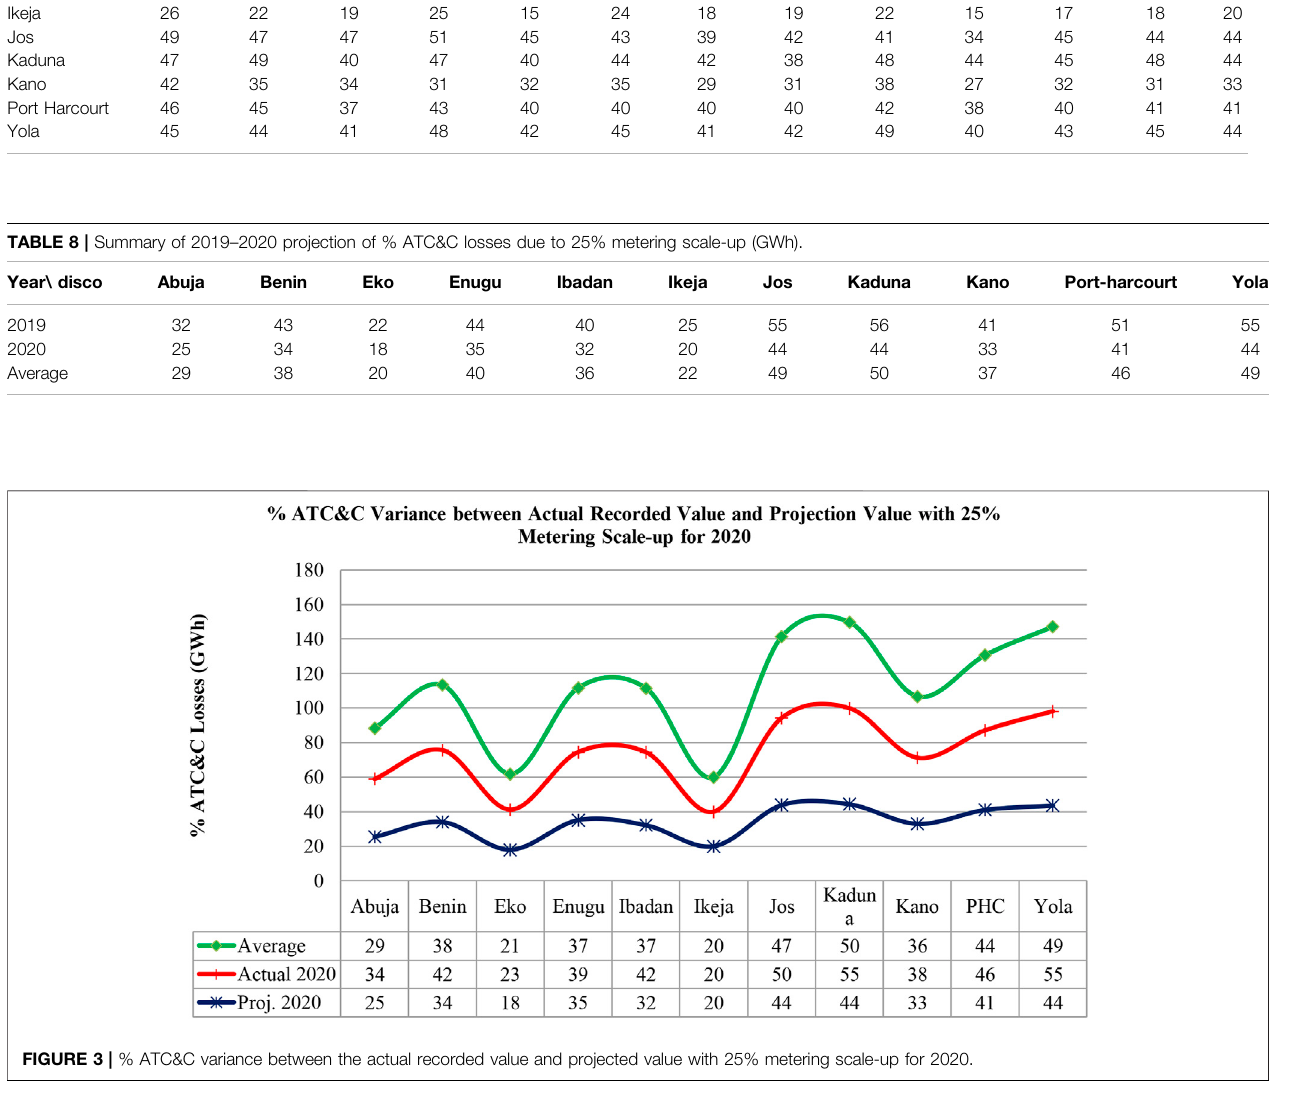
Frontiers in Energy Research |